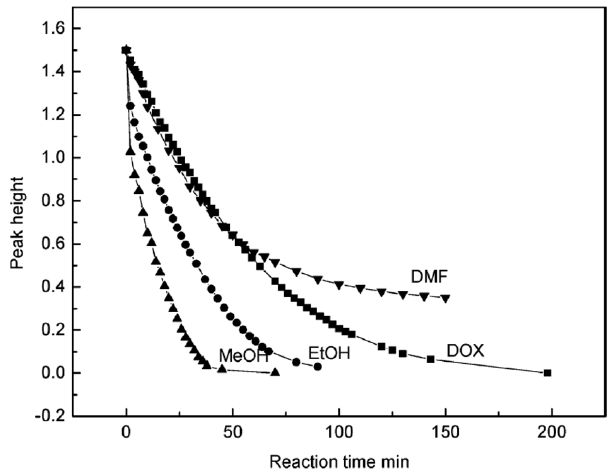
Figure 9. Kinetics of hydrolysis for MTES in an alkaline system for different solvents, inferred from the peak height of MTES at 960.0 cm − 1 . Reprinted with permission from [48]. Copyright American Chemical Society, 2006.